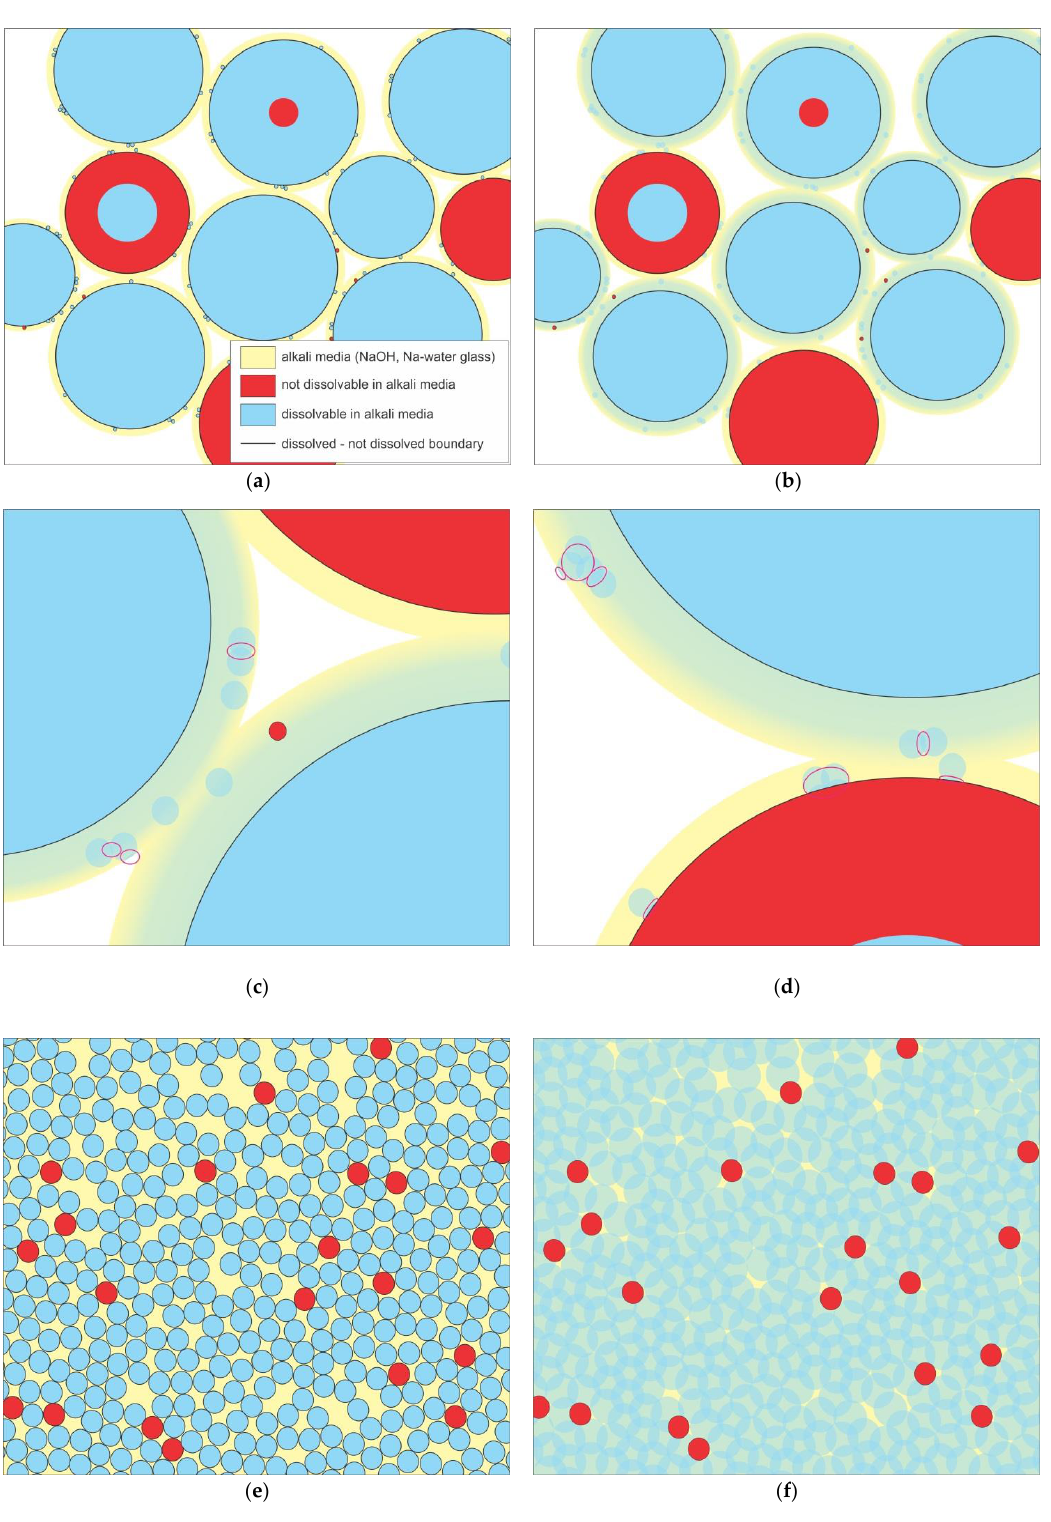
Figure 13. Sketches of early alkali activation process from big ( a – d ) and small ( e , f ) precursor. The 1st step ( a , e ) is wetting of the precursor’s surface, 2nd step ( c , d , f ) is the dissolution of in alkali dissolvable precursor’s ingredients accompanied by diffusion of dissolved ions.